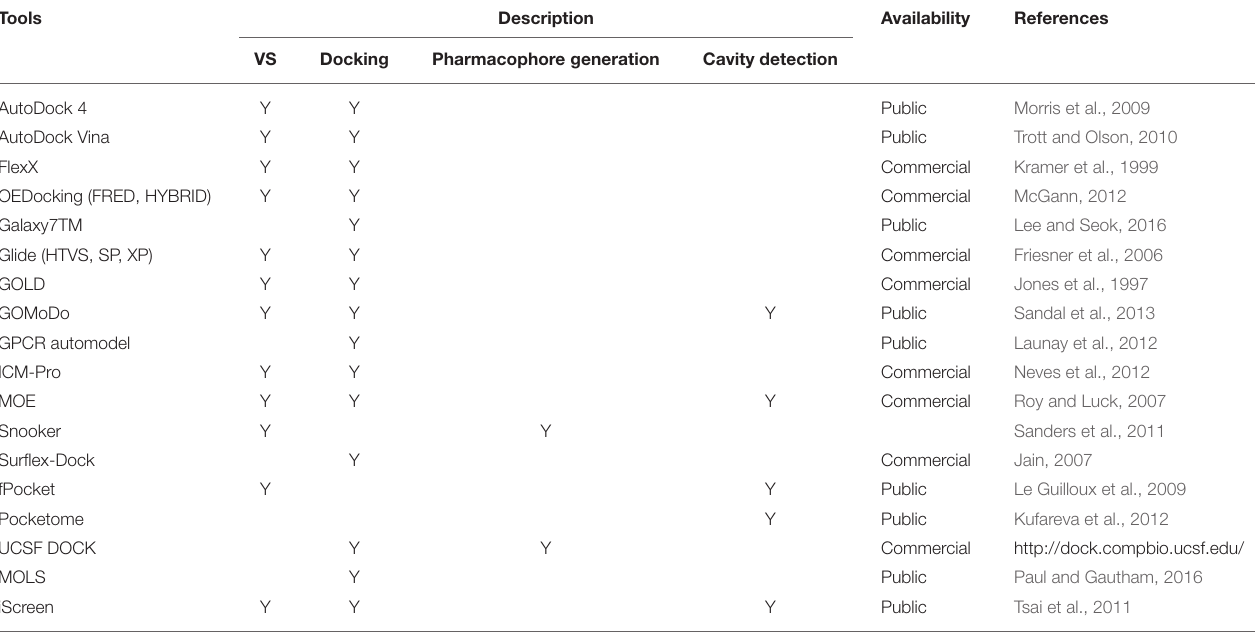
TABLE 3 | Cheminformatics tools for structure-based drug discovery.